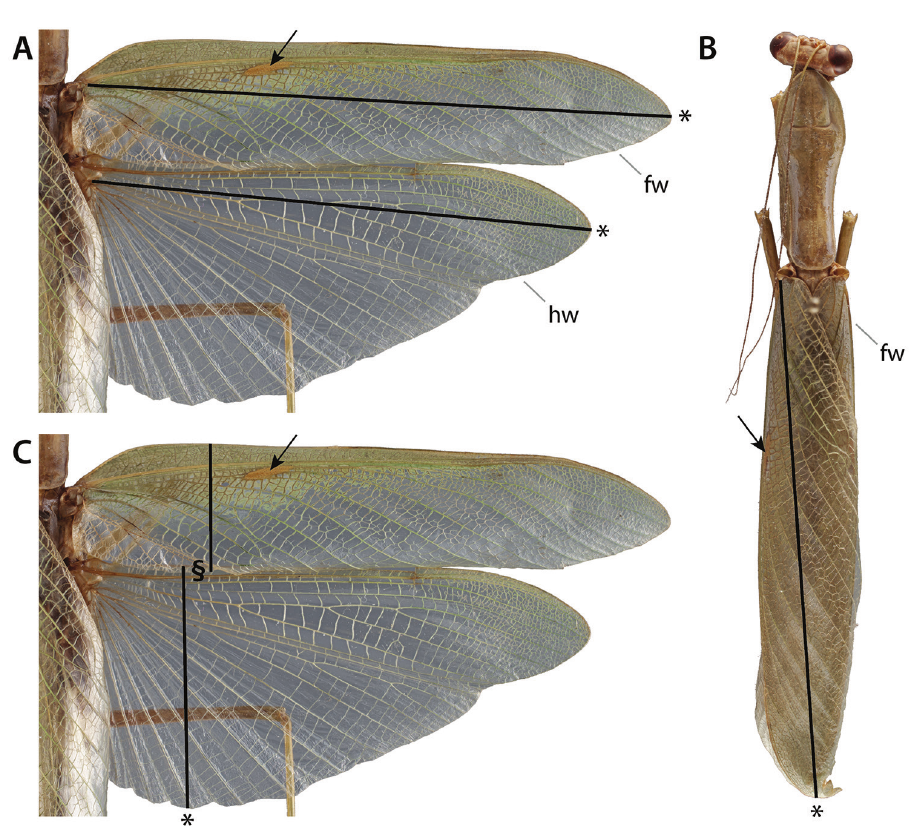
Figure 26. Wing length and width measurement standards. Solid black lines indicate approximate loca- tion to take length and width measurements. Sphodromantis sp. A prepared specimen fore- and hindwing length B unprepared specimen forewing length. Note: in unprepared specimens, hindwing length and fore- and hindwing width is impossible to measure without first relaxing and re-mounting the specimen C prepared specimen fore- and hindwing width. Asterisks (*) represent potential areas where specimen damage ( e.g., wing tip damage) may result in an inability to take an accurate measurement. Sectional sign (§) represents potential area where wing overlap can occur and either great care or re-mounting is needed to take wing width measurements. Black arrows indicate the pterostigma. Abbreviations: fw = forewing; hw =